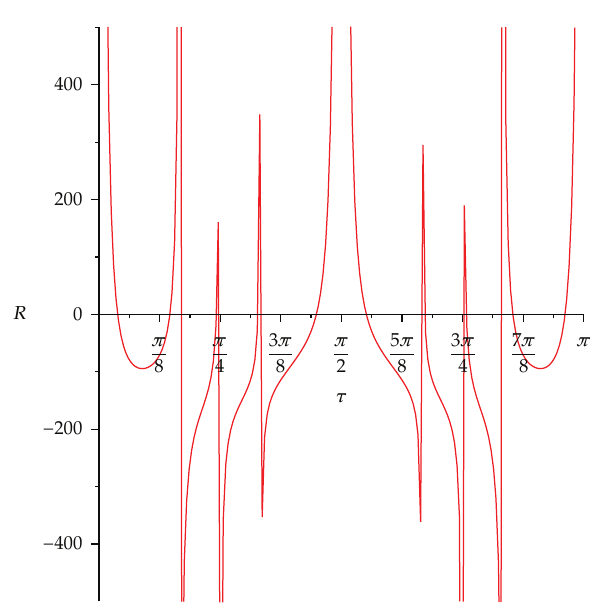
Figure 15: The evolution of the R with respect of the cosmic time τ for (cid:2) 4.6 (cid:3) .